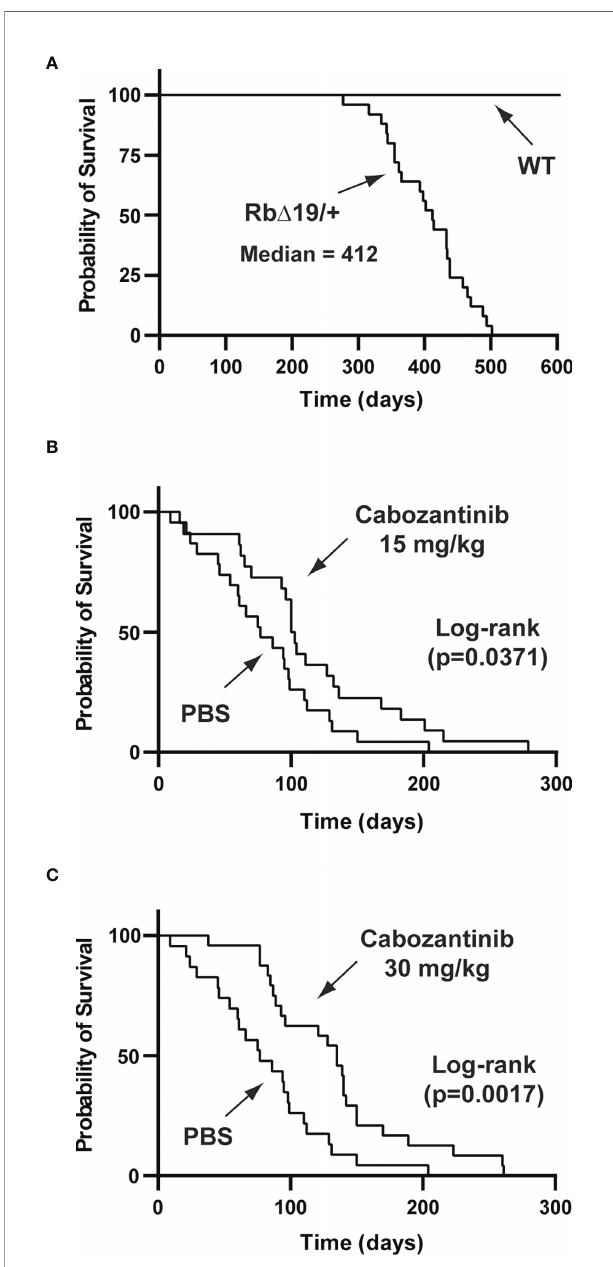
FIGURE 8 | Prolonged survival of Rb D 19 mice by cabozanitinib treatment. (A) Survival of Rb D 19 mice and their WT littermates in the absence of antiangiogenesis treatment. (B) Survival of Rb D 19 mice treated with Cab at 15 mg/kg body weight for two two-week regimens. Mice treated with PBS were as controls. (C) Survival of Rb D 19 mice treated with Cab at 30 mg/kg body weight for two two-week regimens. The treatment was initiated when mice reached 345 days old. Time designated as days after treatment